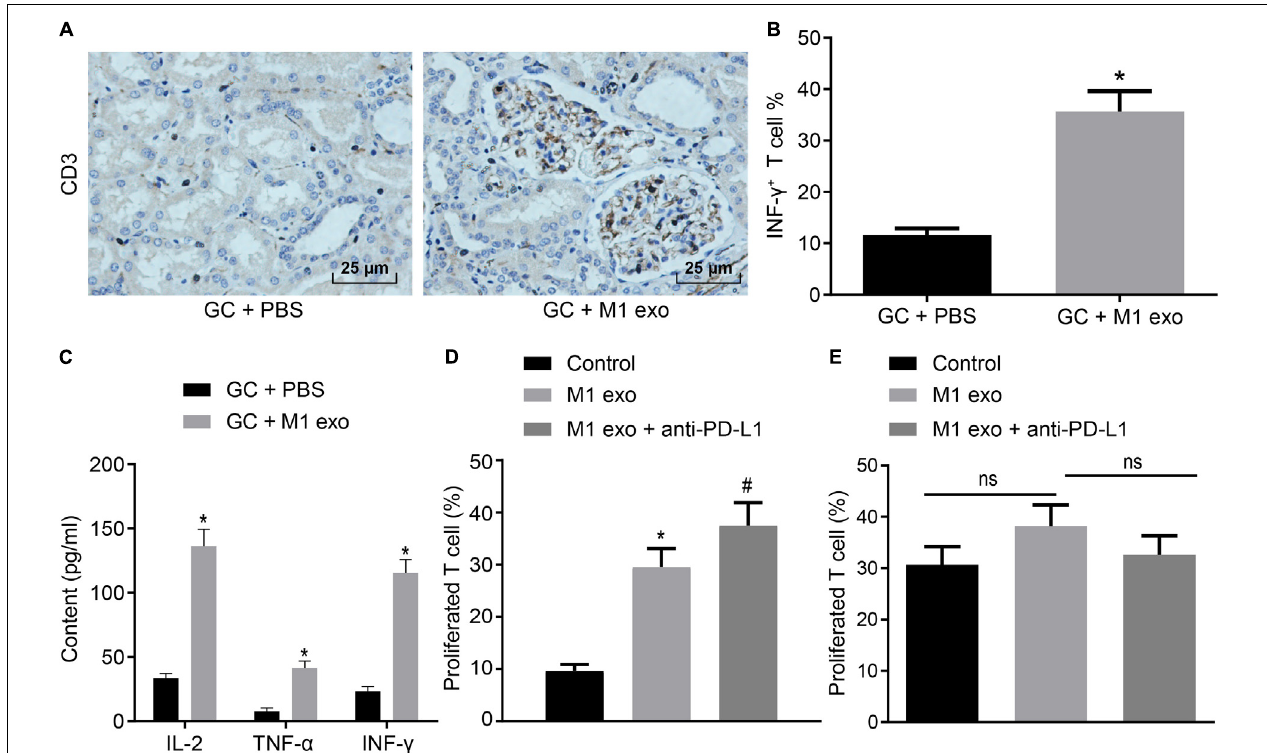
FIGURE 3 | Exosomes derived from M1 macrophages promote the immune response of T cells. Mice are treated with PBS or M1 macrophage-derived exosomes. (A) Immunohistochemistry of CD3 + T infiltration in the tumors of mice (400 × ). (B) Flow cytometry of INF- γ + T cells in CD3 + T cells ( n = 5). (C) ELISA of IL-2, TNF- α and INF- γ expression in the supernatant of T cells ( n = 5). (D) Flow cytometry of PD-1 + T cell proliferation in GC cells treated with M1 macrophage-derived exosomes and anti-PD-L1 after co-cultured with PD-1 + or PD-1 - T cells. (E) Flow cytometry of PD-1 - T cell proliferation in GC cells treated with M1 macrophage-derived exosomes and anti-PD-L1 after co-cultured with PD-1 - T cells or PD-1 - T cells. * p < 0.05 compared to mice treated with PBS as well as in comparison to the GC cells without any treatment; # p < 0.05 compared with GC cells treated with M1 macrophage-secreted exosomes. Measurement data representative of three independently conducted experiments expressed as mean ± standard deviation. Comparisons between two groups analyzed by non-paired t test as well as comparisons among multiple groups are analyzed by one-way ANOVA. Post hoc test was conducted using Tukey’s